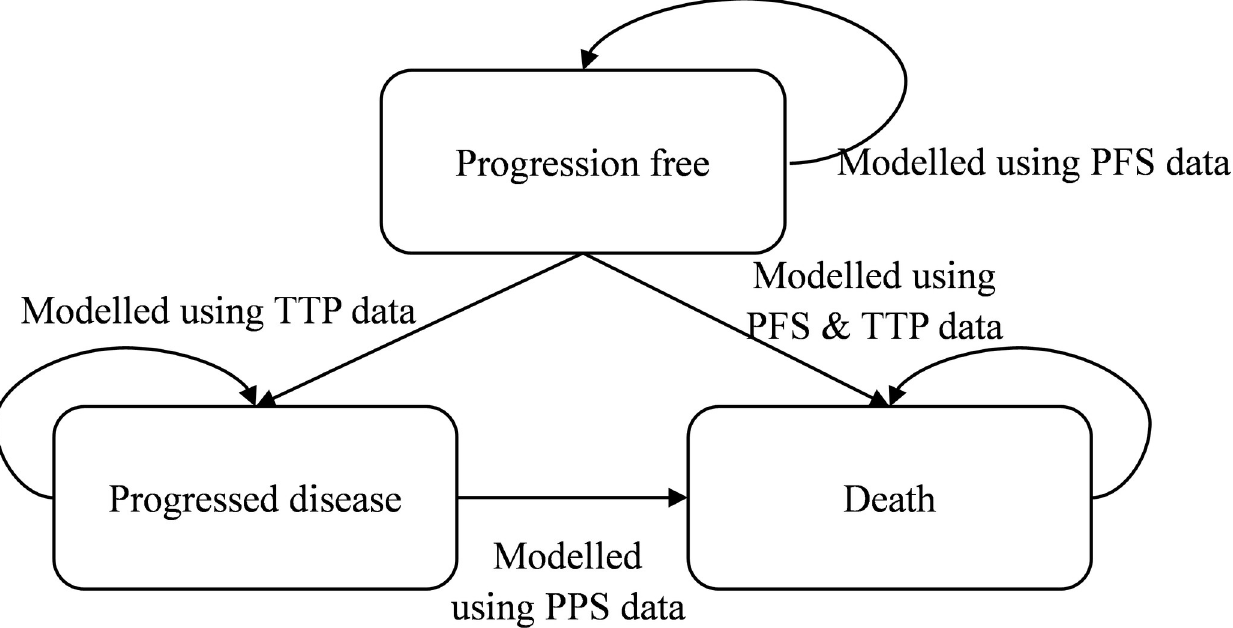
Fig 1. Markov model structure. The health-state structure was published previously as part of the UK National Institute for Care and Excellence single technology appraisal committee papers [22]. PFS, progression free survival; TTP, time to progression; PPS, post-progression survival.